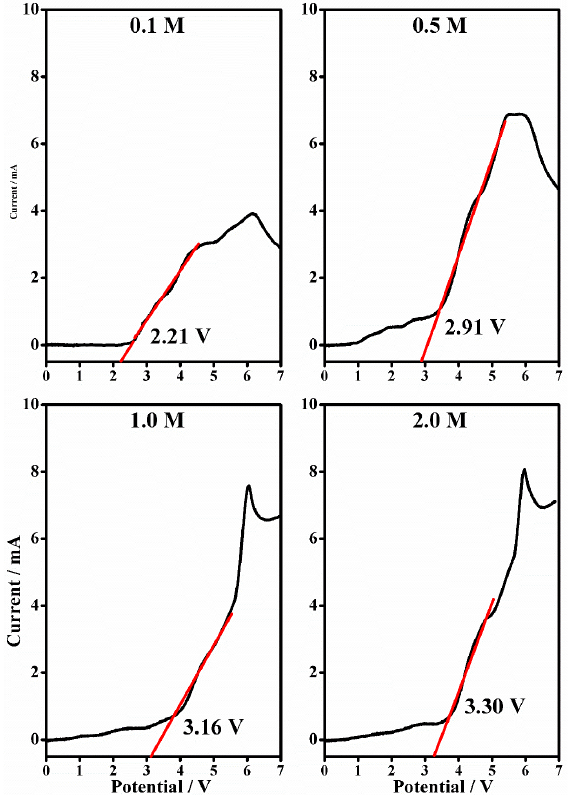
Figure 15. The Linear sweep voltammetry (black line) from 0 to 7 V and in the current range between 0 and 200 mA (scan rate 10 mV/s) and the anodic stability (relative linear fit, red line) of PMMA-Li-PC gel polymer electrolyte at different salt concentrations: 0.1 M, 0.5 M, 1 M and 2 M.